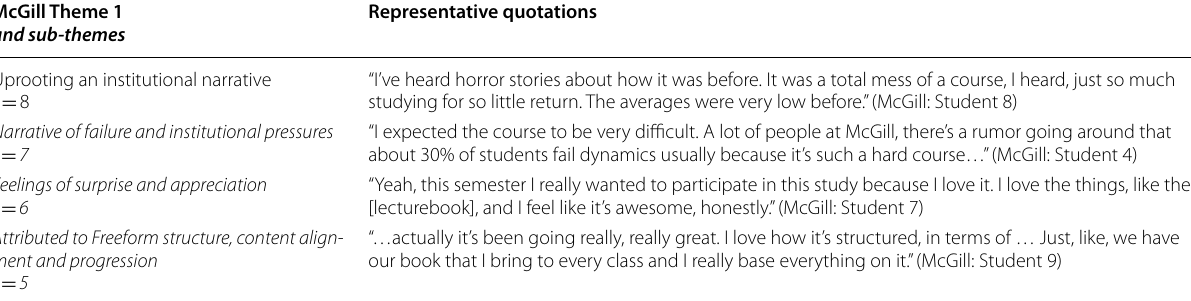
Table 3 McGill institutional analysis—Theme 1 McGill Theme 1 and